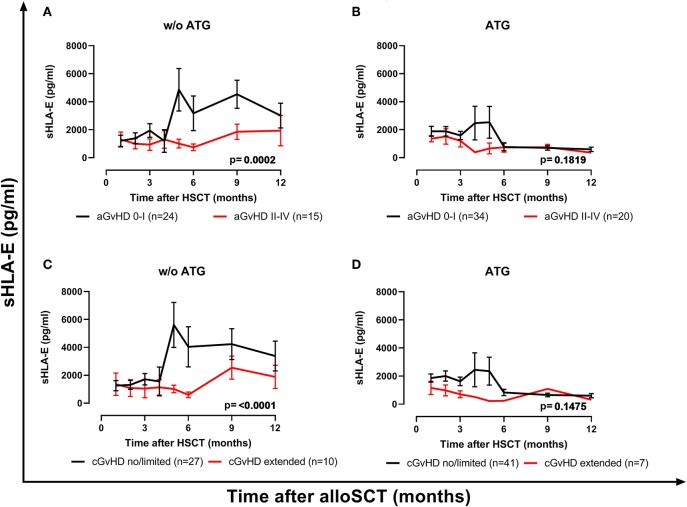
The impact of ATG conditioning on the course of sHLA-E levels with respect to GvHD. sHLA-E levels in non-ATG-treated patients (A,C) and ATG-treated (B,D) were stratified according to the manifestation of severe aGvHD (A,B) or extended cGvHD (C,D). In patients without (w/o) ATG treatment (A,C) but not in ATG-treated patients (B,D) sHLA-E levels were significantly lower in patients experiencing aGvHD grade II–IV (red line) or extended cGvHD compared to patients with aGvHD patients grade 0–I (black line) or no/limited cGvHD. Manifestation of aGvHD or cGvHD could not be evaluated for all patients due to death or missing clinical data.